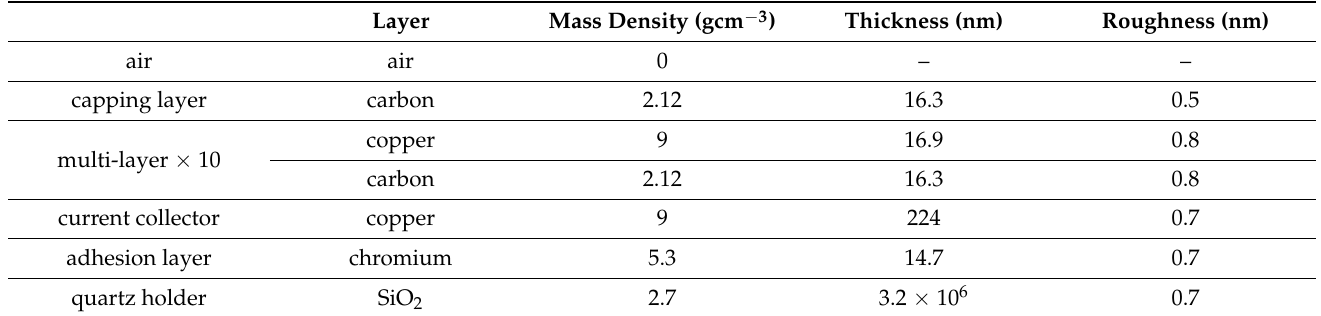
Table 1. Parameters used for the simulation of the X-ray reflectivity pattern (shown later in the next section) by the Parratt32 code, i.e., for the as-deposited C/Cu ML electrode. Layer Mass Density (gcm − 3 ) Thickness (nm) Roughness (nm) 0 –